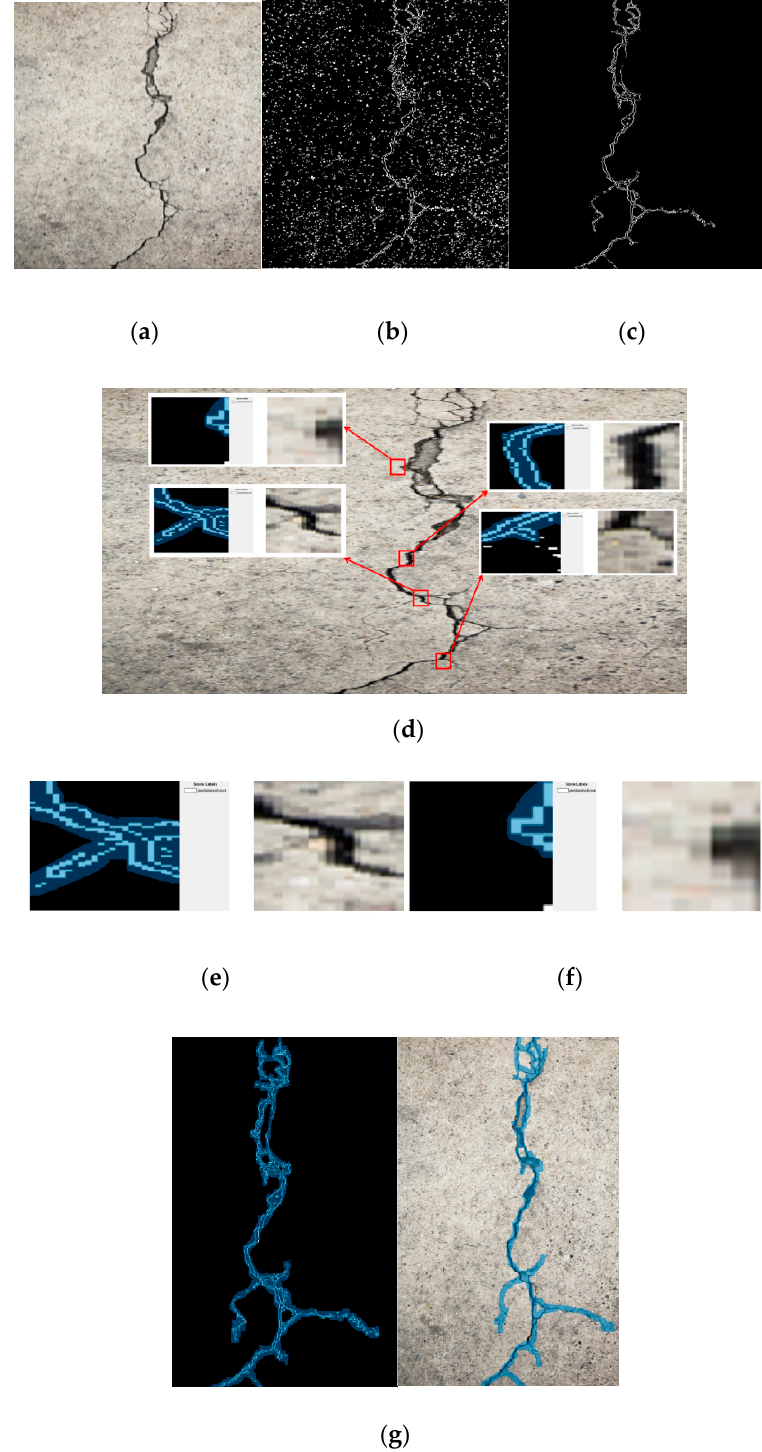
Figure 11. ( a ) Expansion diagram of the inner wall of the pipe. ( b ) The effect diagram of the mean value binarization. ( c ) The effect diagram of local binarization (range 5 × 5). ( d ) The schematic diagram of data label is made according to the ground truth in the patch. ( e ) The ground truth accounted for more than 20% of all pixels in the patch, which was denoted as a crack patch. ( f ) The ground truth and all pixels in the patch accounted for less than 20%, this was recorded as suspected data and not sent to the network for learning. ( g ) Ground truth mapping for the whole image.